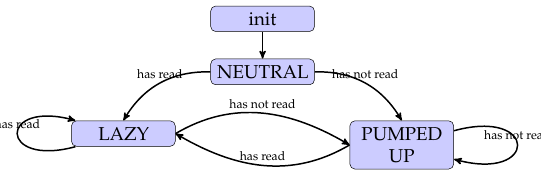
Figure 4. Priority levels